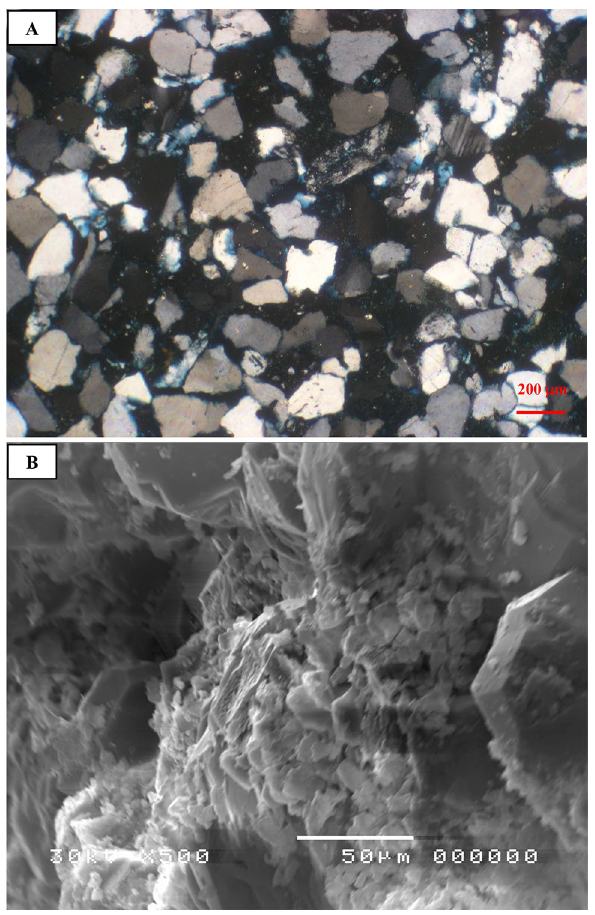
Fig. 3 Photomicrograph of high-porosity quartz arenite with fresh and altered feldspar, S#15, group (A), ϕ = 28.8%, K = 257mD. a CN, b SEM